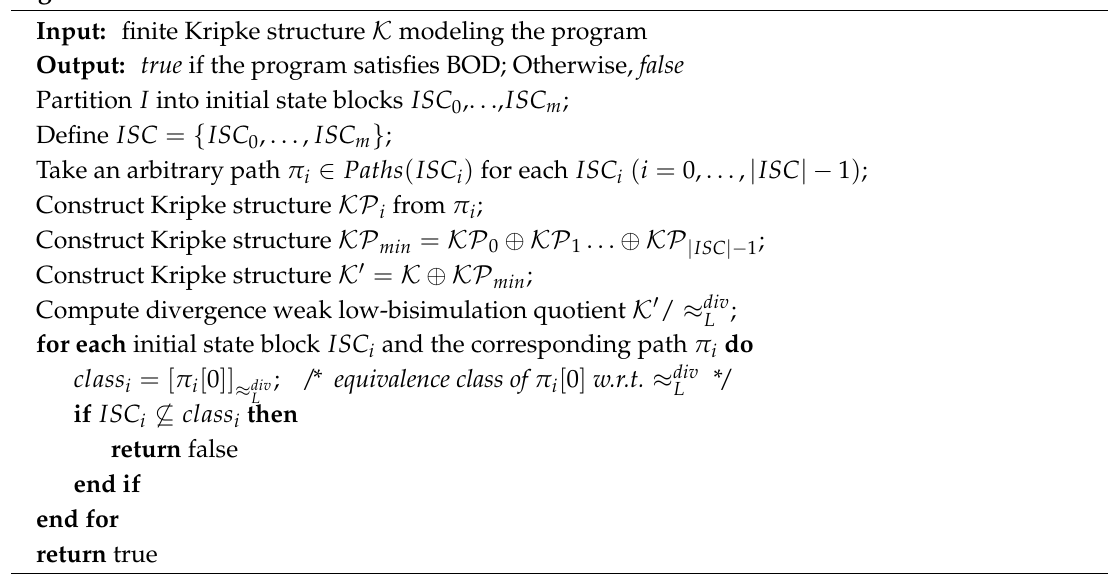
Algorithm 1 Verification of